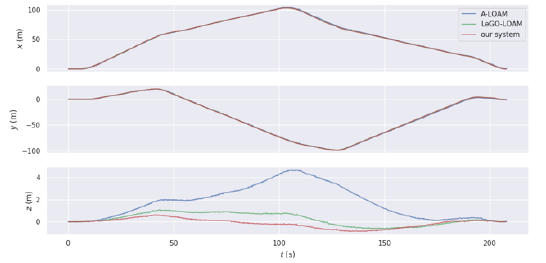
Figure 8. Translation difference of building .